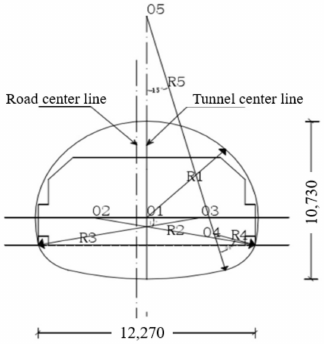
Figure 1. Inner contour section of the tunnel (unit: